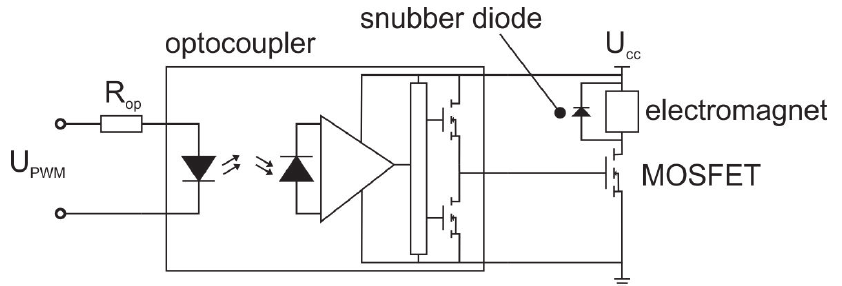
Figure 7. The scheme of the actuator.